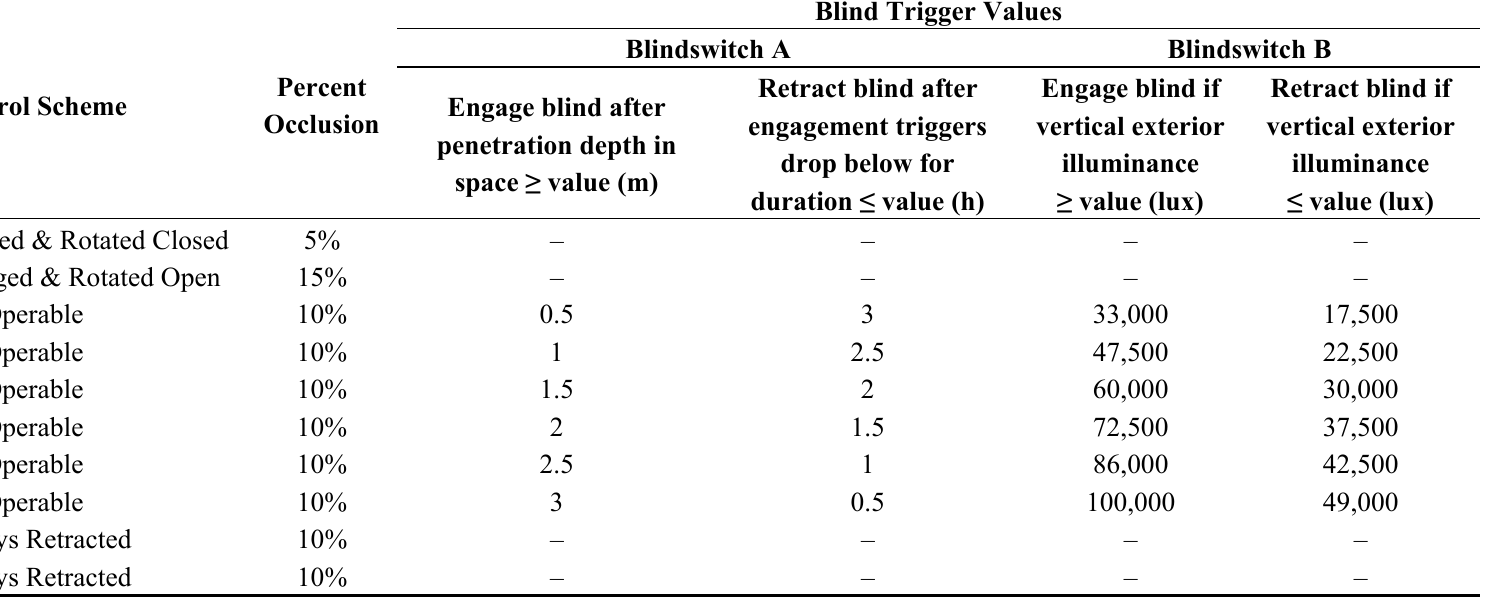
Table 2. Trigger values for manual blind control algorithm (Blindswitch A and